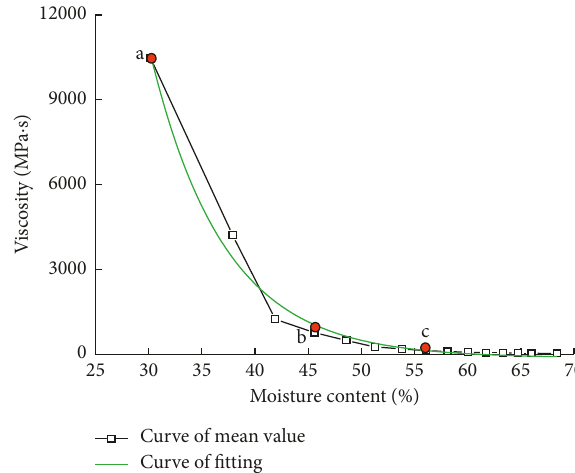
Figure 3: The curves of mud viscosity of different particle sizes under different moisture